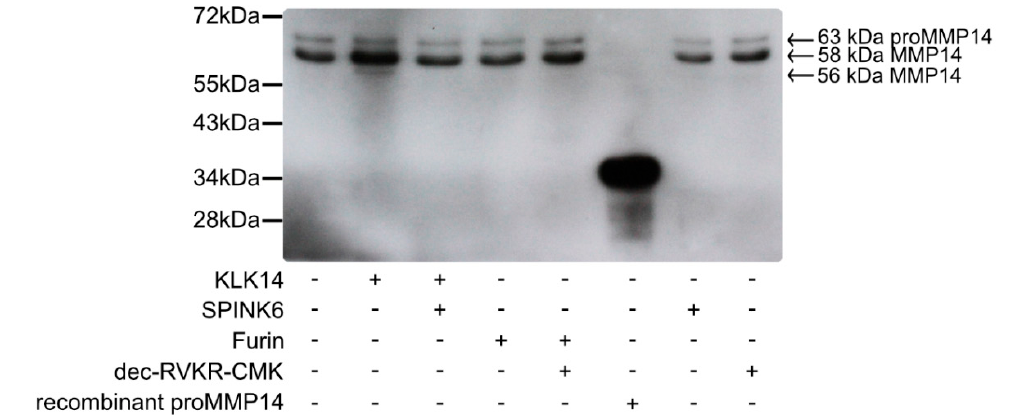
Figure 6. Processing of cell surface proMMP14 by KLK14. Murine fibroblasts stably expressing human MMP14 (MT1-MMP) were treated with KLK14 and furin. Selective inhibitors serine protease inhibitor Kazal-type 6 (SPINK6) (KLK14) and dec-RVKR-CMK (furin) were used to inhibit KLK and furin in the control samples. Cell surface proteins were then biotinylated, and streptavidin bead immunoprecipitates were subjected to immunoblotting using an anti-MMP14 antibody. Each sample contained the 63 kDa proMMP14 form, whereas an increase in the active 58 kDa MMP14 form was observed after KLK14 incubation. Additionally, a lower molecular weight MMP14 form at 56 kDa was detected only in the KLK14 treated sample. KLK = kallikrein-related peptidase; MMP = matrix metalloproteinase.